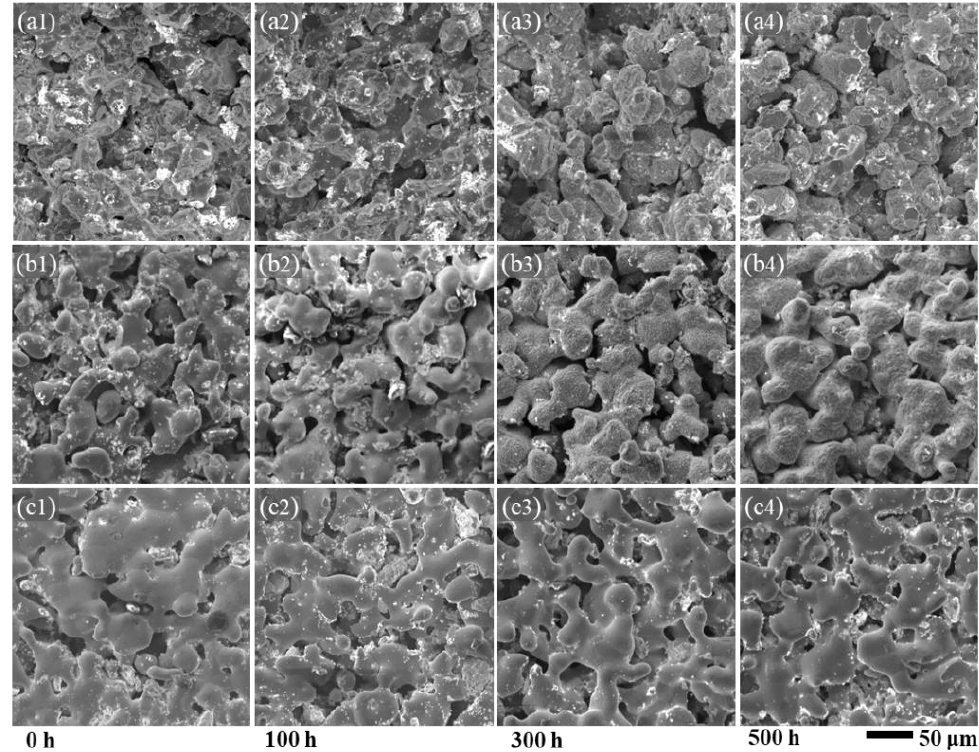
Figure 6. SEM images of porous Fe20Cr5Al ( a1 – a4 ), Fe10Cr10Al ( b1 – b4 ), Fe10Cr20Al ( c1 – c4 ) after aging for 0 h, 100 h, 300 h and 500 h, respectively.